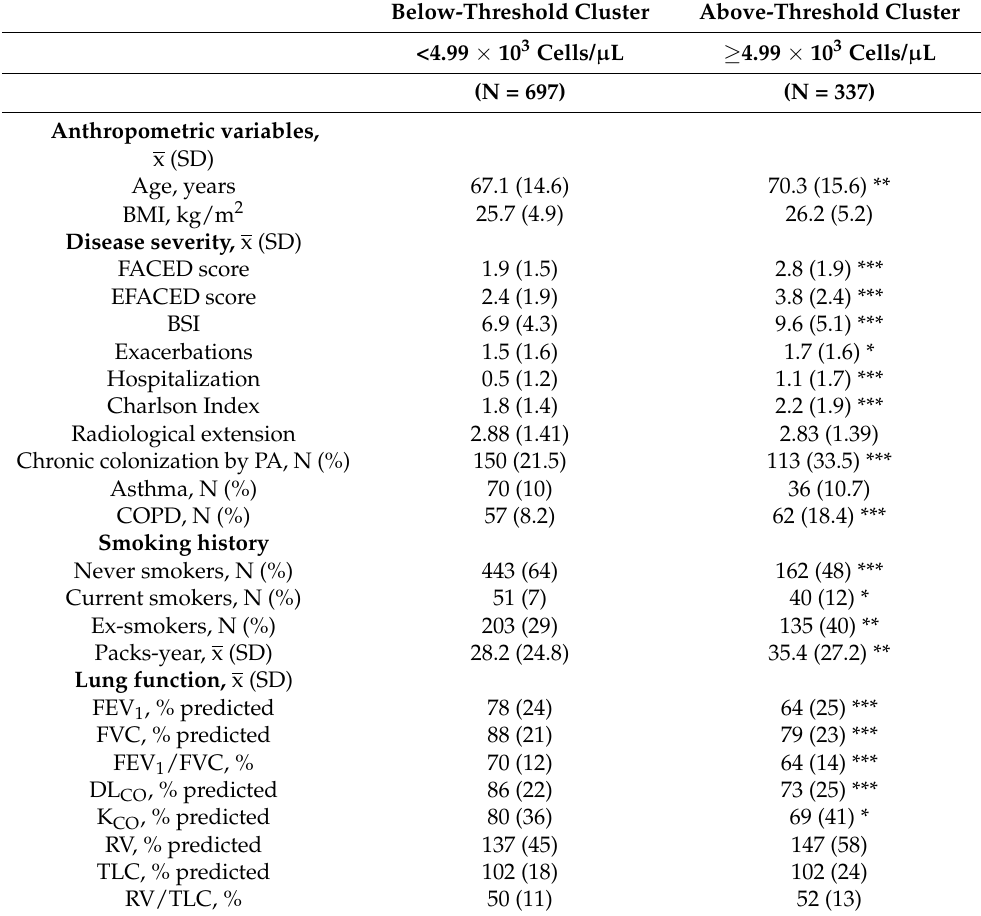
Table 1. General characteristics of all the study patients according to the two clusters of